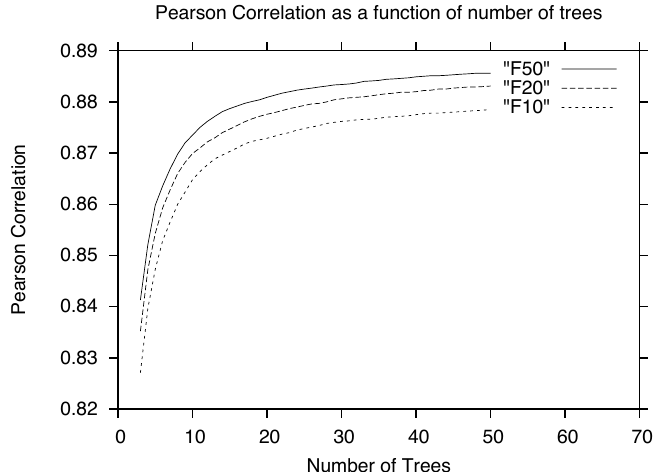
Figure 4. Similar to Figure 3, the Pearson correlation between the fraction of GZ1 humans voting for spiral, and our reproduction of that fraction, as a function of the number of trees in the forest. The three curves also show how the results change when the number of features per tree is 10, 20, or